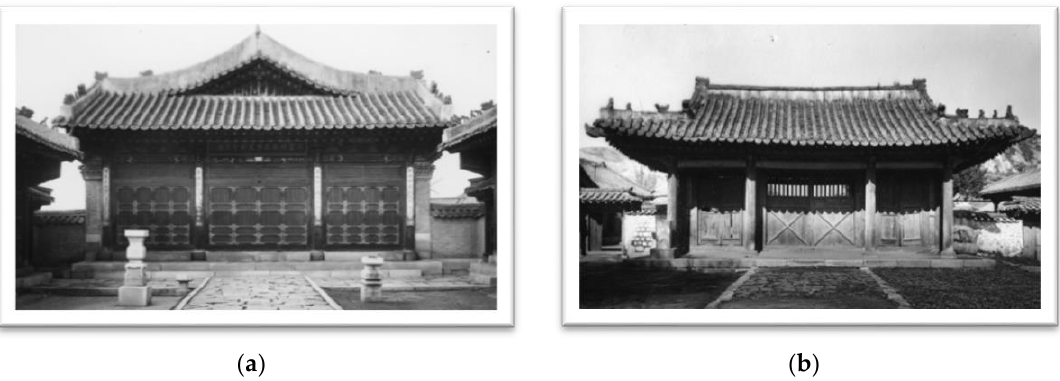
Figure 2. The South Shrine ( a ) and the East Shrine ( b ). (photographs held at the Korean National Museum).